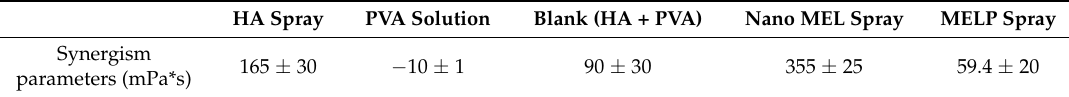
Table 1. Calculated synergism parameters at shear rate of 1001/s of spray